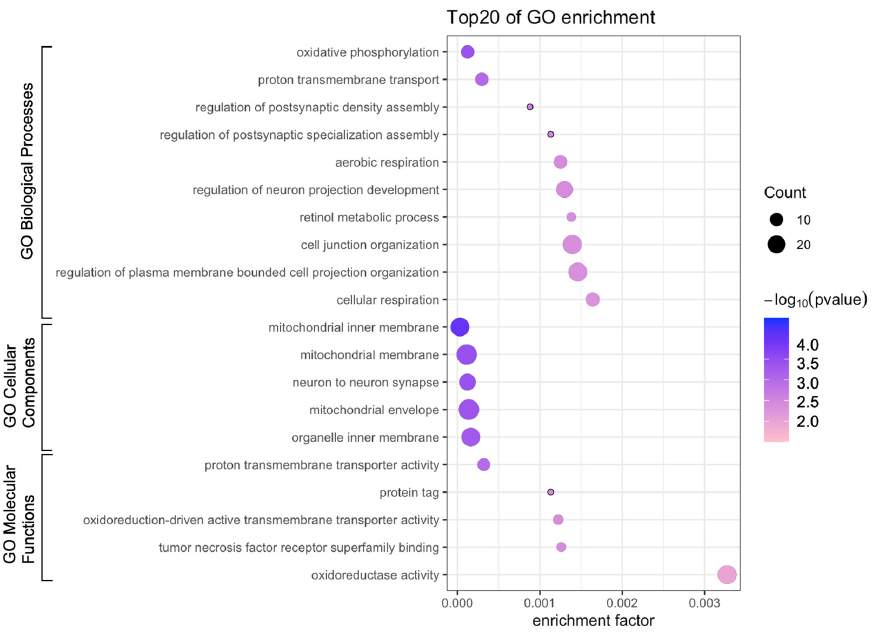
Figure 4. Bubble diagram of Gene Ontology (GO) enrichment analysis. Bubble size represents the number of differentially expressed genes. Table 2. Gene Ontology (GO) analysis of low-dose UVA-related differentially expressed genes. Go Number